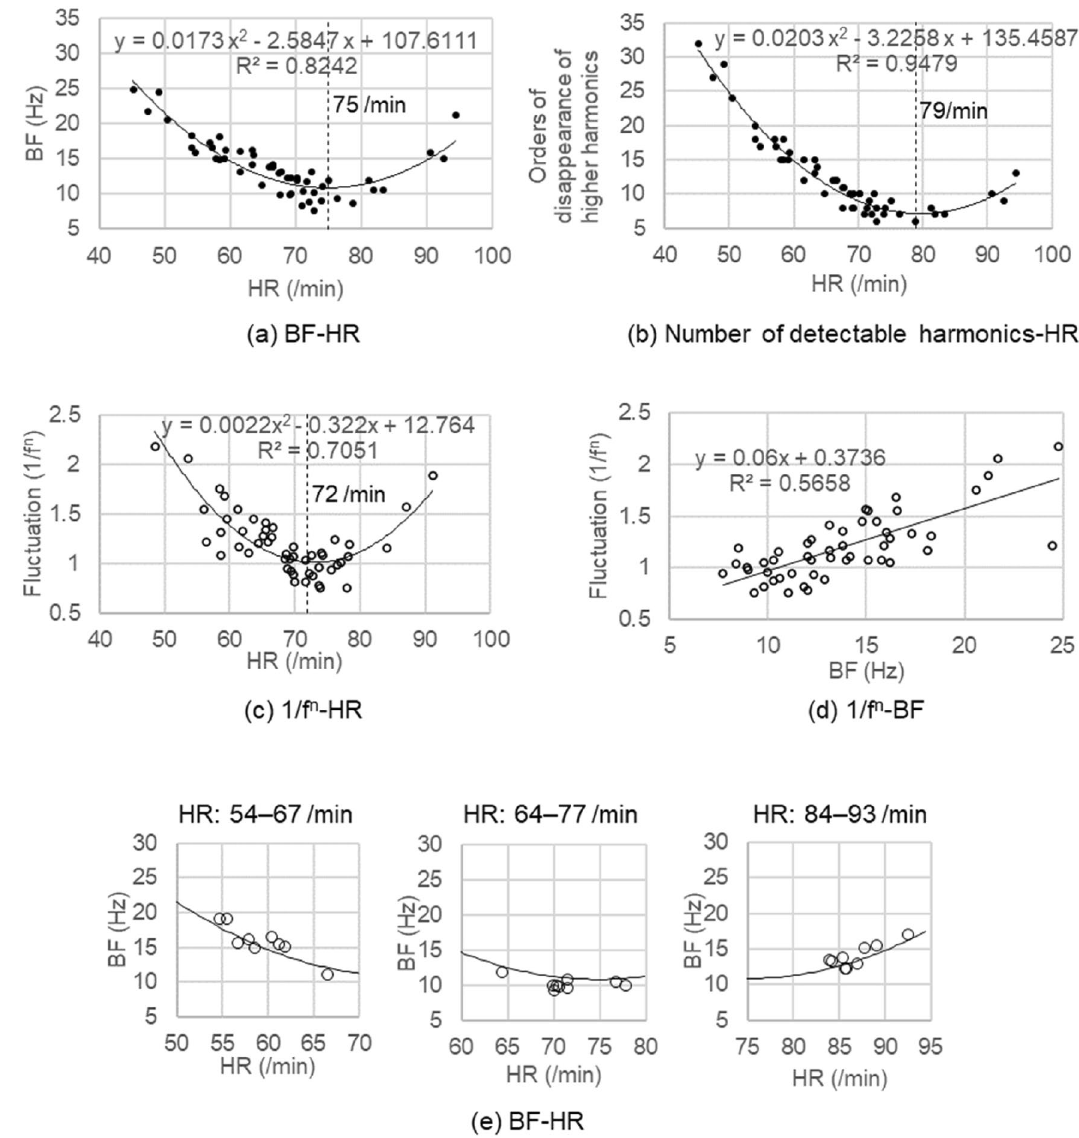
Figure 5. Correlation diagram of heart rates, BF, orders of disappearance of higher harmonic vibration, and 1/f n . ( a ) Correlation diagram of BF-HR, ( b ) number of detectable harmonics-HR and ( c ) 1/f n -HR were represented by a quadratic function.( d ) 1/f n -BF was approximated by a linear function. The fluctuation became 1/f (|n|= 1) when BF was in the vicinity of 8 to 12 Hz and heart rate was around 72/min. On the other hand, the fluctuation was 1/f 2 (|n|= 2) when BF was more than 20 Hz and heart rate was in the vicinity of either 50 or 90/ min. ( e ) When variation of heart rates of the three subjects occurred under respiratory depression at rest, BF moved along the quadratic curve of the BF-HR correlation diagram shown in (a)